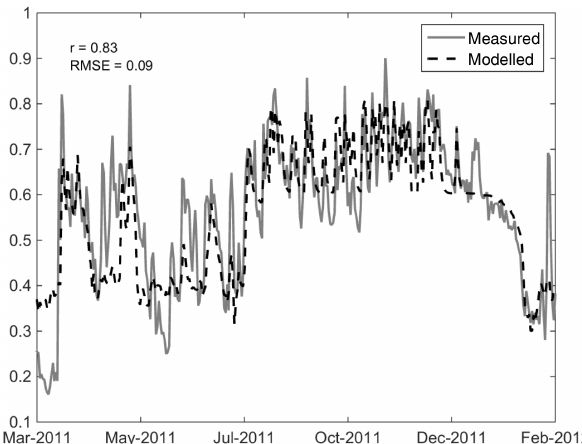
Figure 3. Daily mean values of measured and modelled α for the 358 day mass balance year 2 March 2011 until 22 February